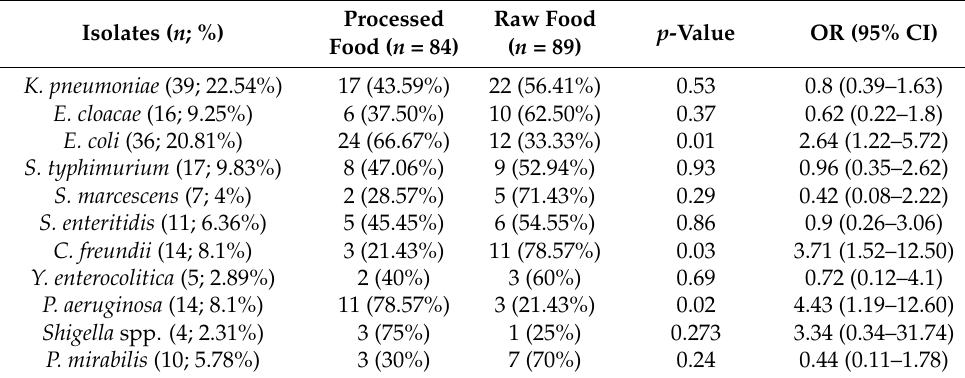
Table 3. Gram-negative isolates from processed and raw food samples ( n = 408).